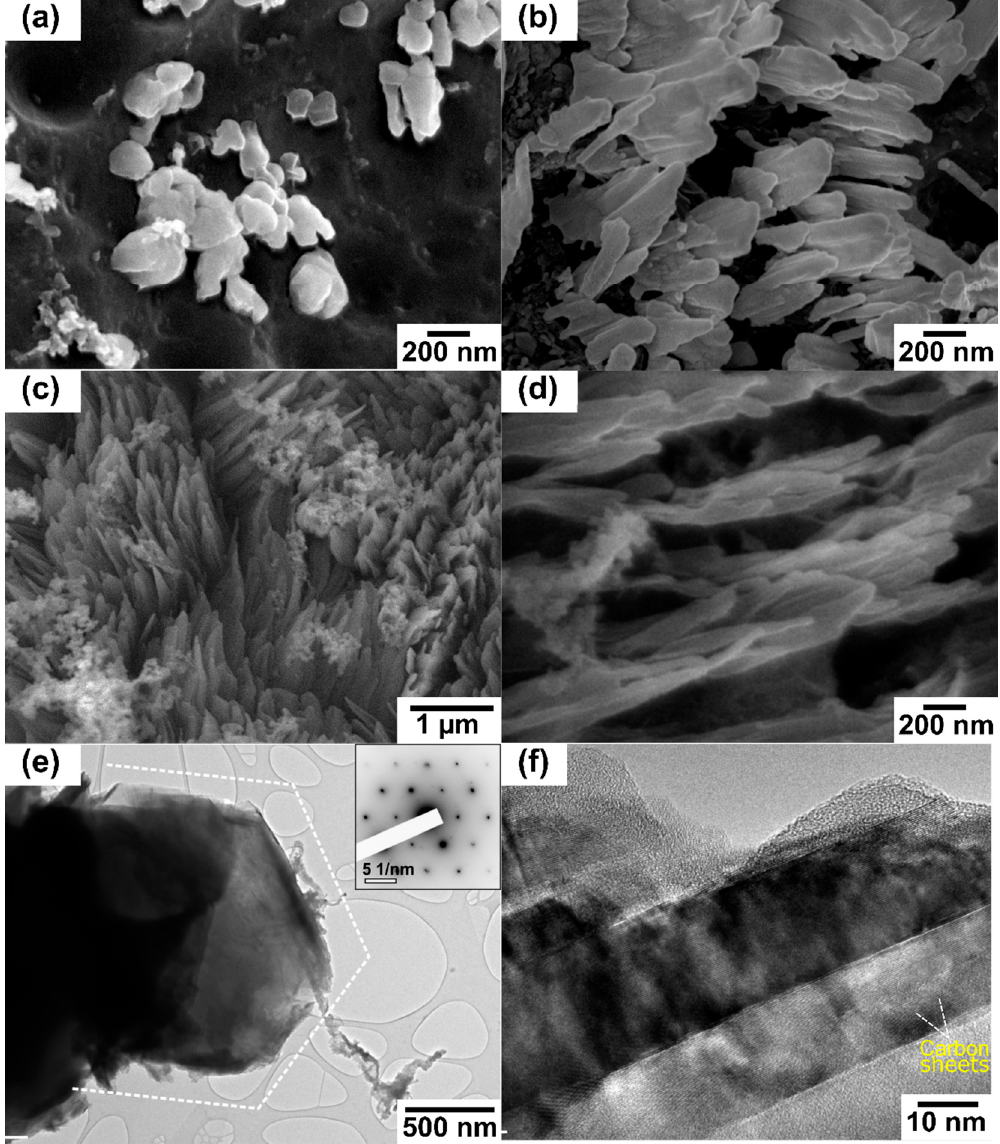
Figure 2. High-resolution SEM micrographs of the carbon nanostructure formation during the time-dependent growth at 250 W and 100:50 sccm after: ( a ) 3 min; ( b ) 5 min; ( c ) and ( d ) 8 min treatment; ( e ) overview TEM micrograph of individual graphite-like hexagonal flake (diffraction in inset), and ( f ) side-view of graphite-like flake, showing several stacks of well-crystalline carbon structures.